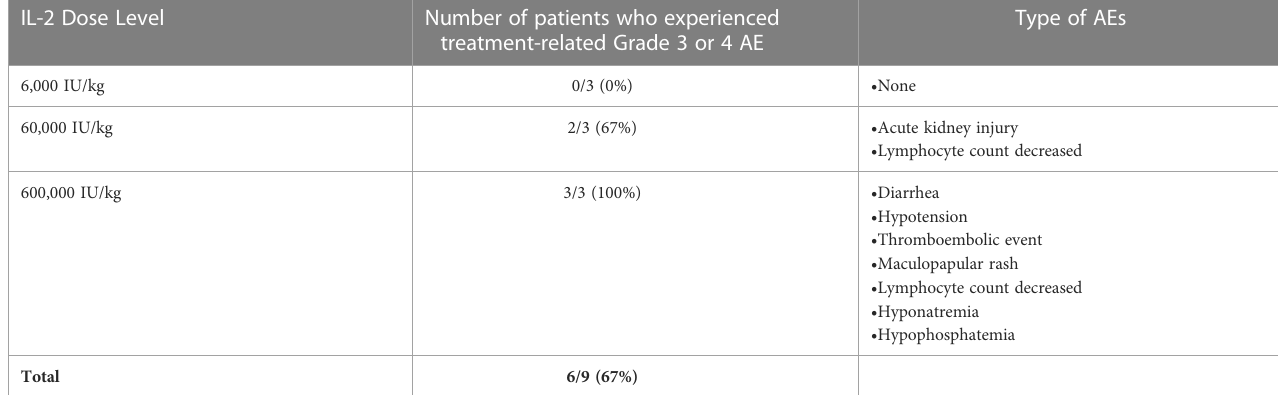
TABLE 3 Grade 3 and 4 adverse events related to one or both study drugs, by IL-2 dose